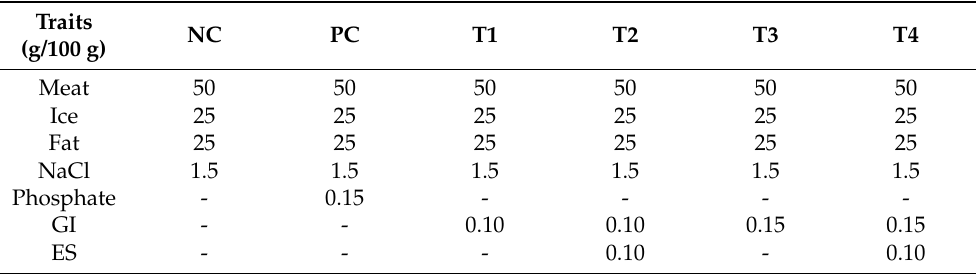
Table 1. Basic formulation of meat emulsion contained grafted insect protein with reducing sugar (GI) and eggshell